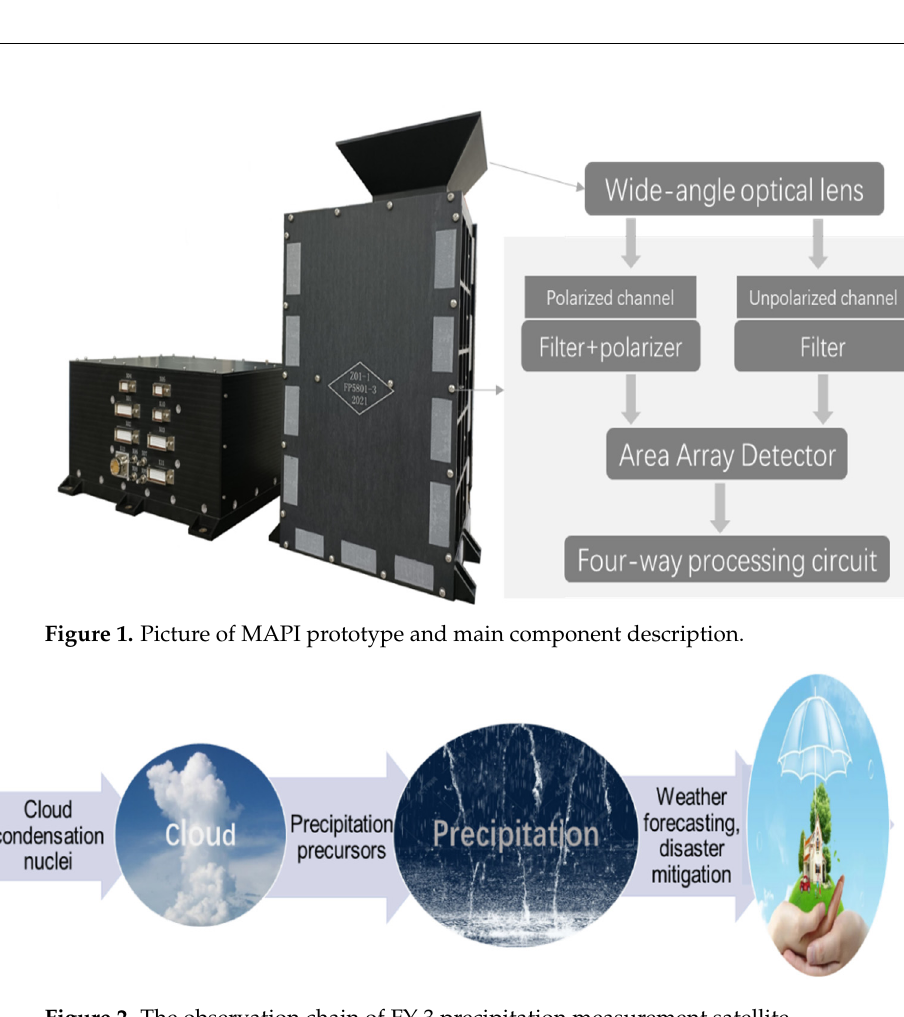
Figure 2. The observation chain of FY-3 precipitation measurement satellite. Table 2. Specifications of